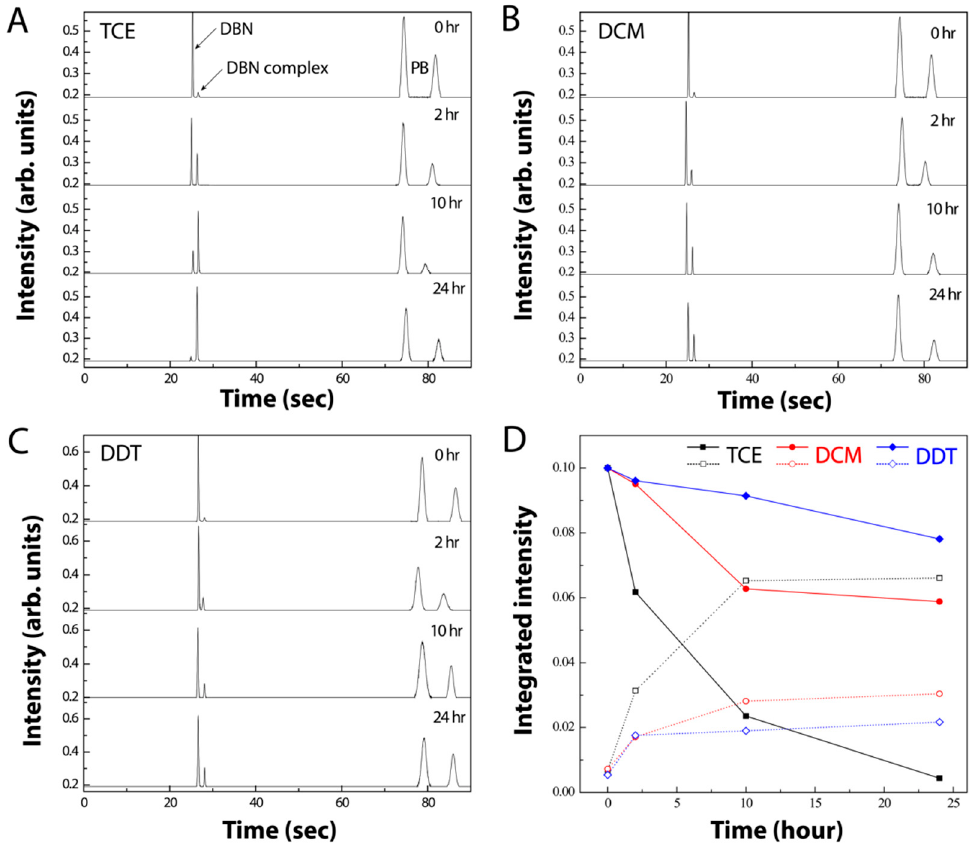
Figure 4. Electropherograms of the mixtures of DBN and organochlorides ( A ) TCE, ( B ) DCM, and ( C ) DDT, measured at different reaction times. From the control experiments, there are no obvious peaks that appeared from DBN + PB and TCE + PB. Peak intensities reflect the concentration of PB-coupled chemical species. ( D ) Conversion yield plots obtained from the area of DBN and organochloride-DBN complex peaks with reaction times. Solid lines with closed circles for DBN; dotted lines with open circles for organochloride-DBN complex.